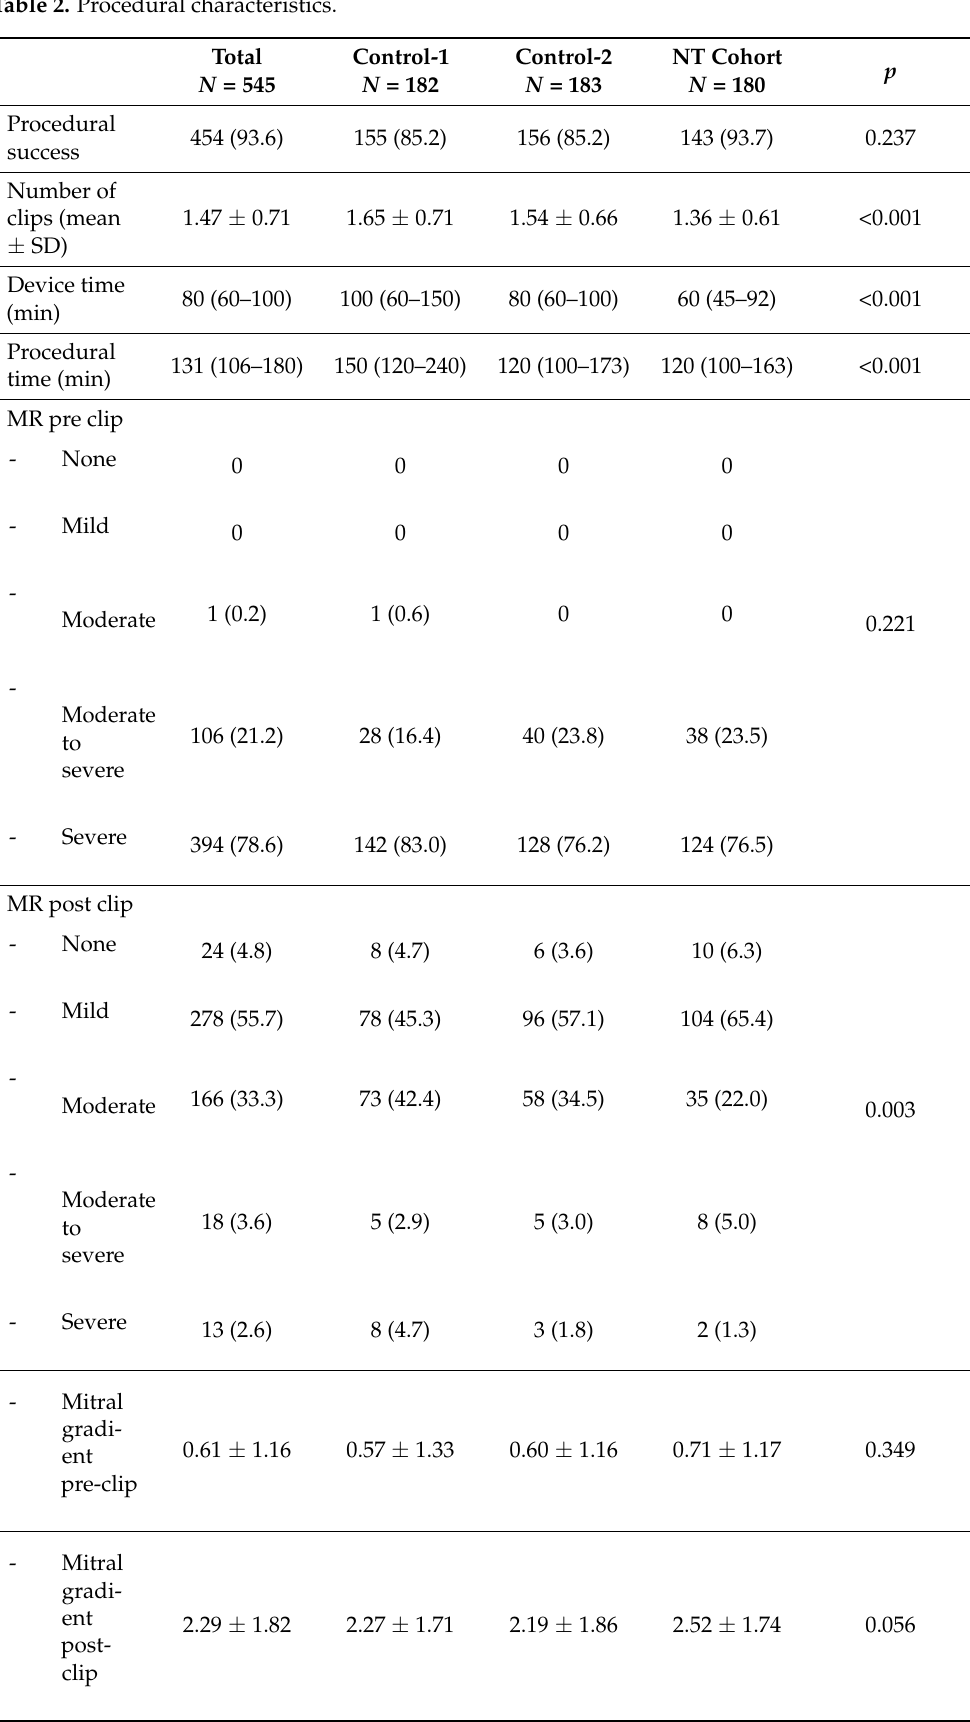
Table 2. Procedural